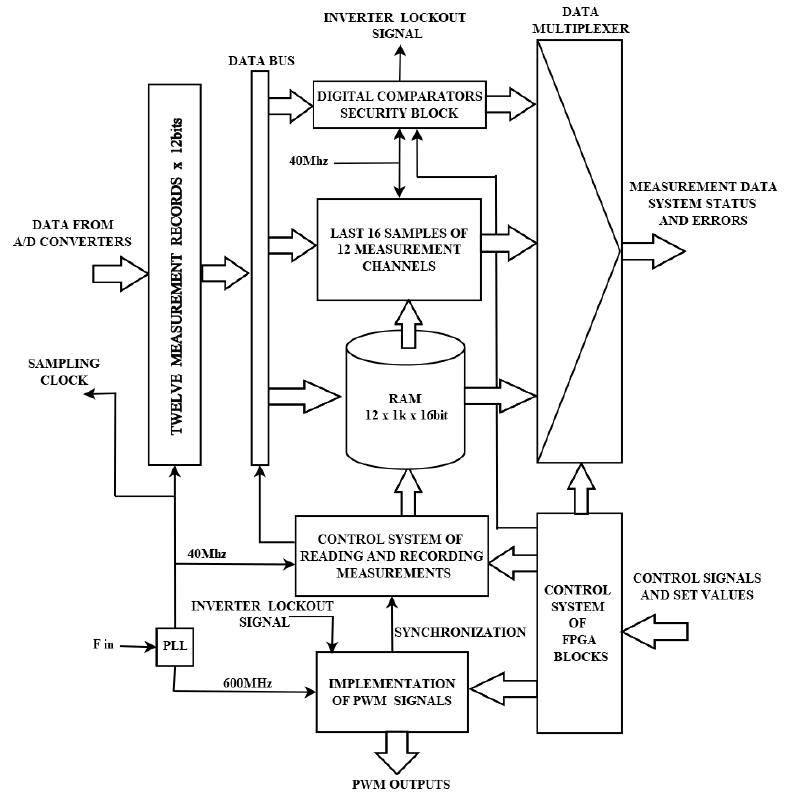
Figure 12. Block diagram of the FPGA structure.